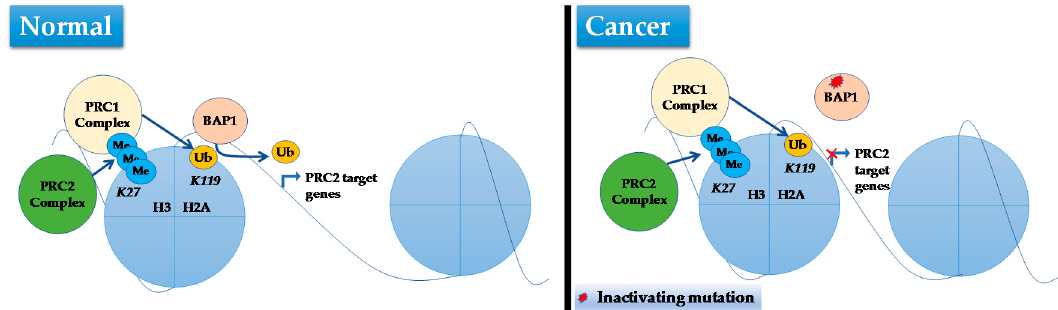
Figure 3. Role of BAP1 in regulation of polycomb target genes. Polycomb Repressive Complex (PRC) 2 mediates H3K27 trimethylation that triggers recruitment of PRC1 complex to H2K27me3 sites where PRC1 complex silences gene expression through monoubiquitylation of H2AK119. In normal conditions, BAP1 can contribute to the removal of ubiquitin from H2AK119ub, establishing a balance between ubiquitination and deubiquitination of H2AK119ub that regulates expression of polycomb target genes. This balance is disrupted when BAP1 is mutated in ccRCC, resulting in dysregulation of polycomb target genes.